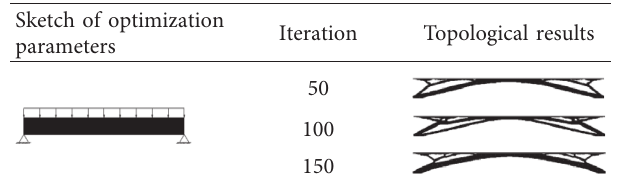
Table 9: Topological result of typical beam/arch.